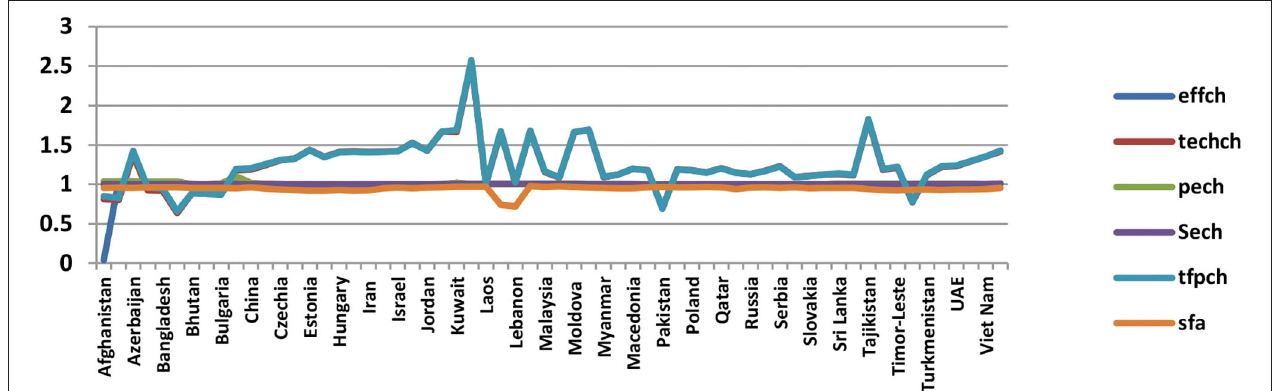
FIGURE 2 | Economic efficiency analysis obtained by DEA and